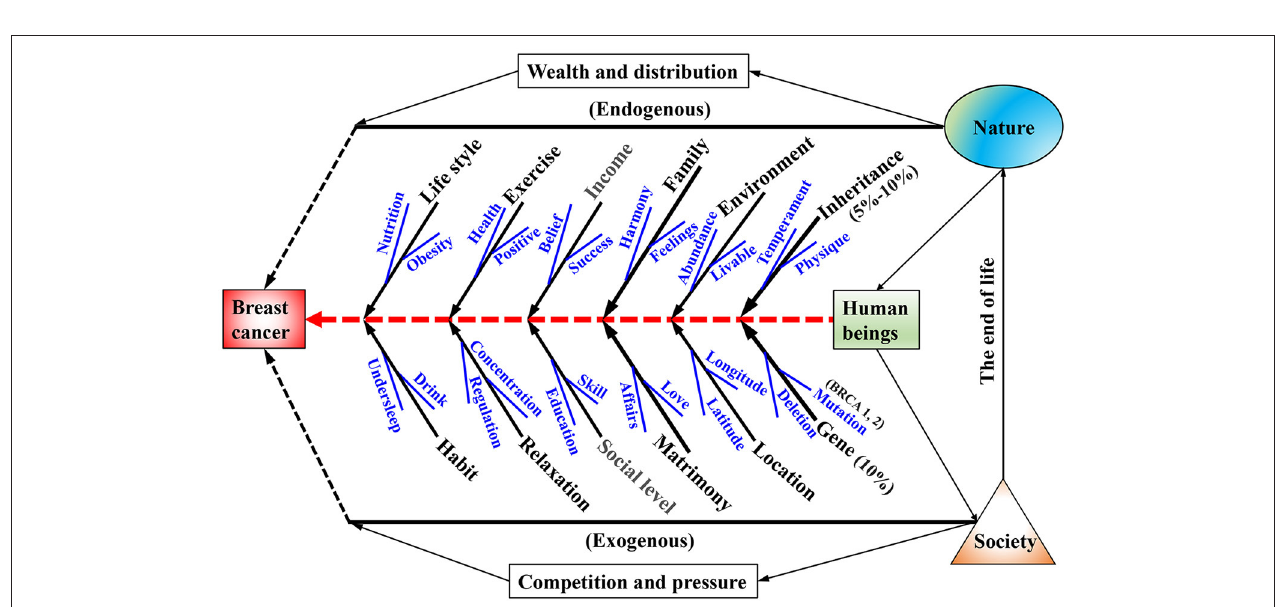
FIGURE 4 | Fishbone diagram of the affecting factors both from nature and society on the female breast cancer.